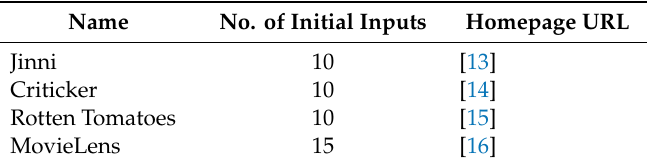
Table 1. Number of movies that a new user has to